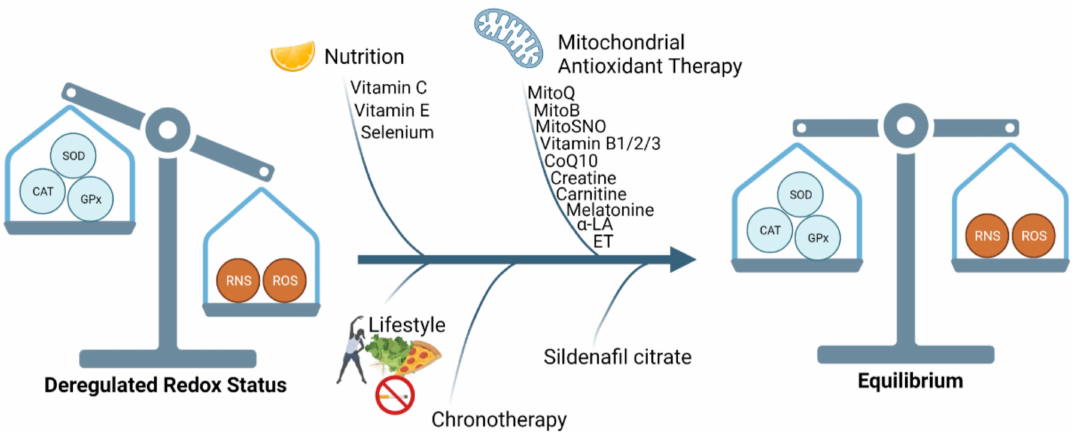
Figure 4. Interventions for Redox imbalance. Nutrition, lifestyle changes, chronotherapy, mitochon- drial antioxidant therapy and sildenafil citrate interventions have been proven beneficial or are under investigation. alpha-LA = α -Lipoic Acid; ET = L